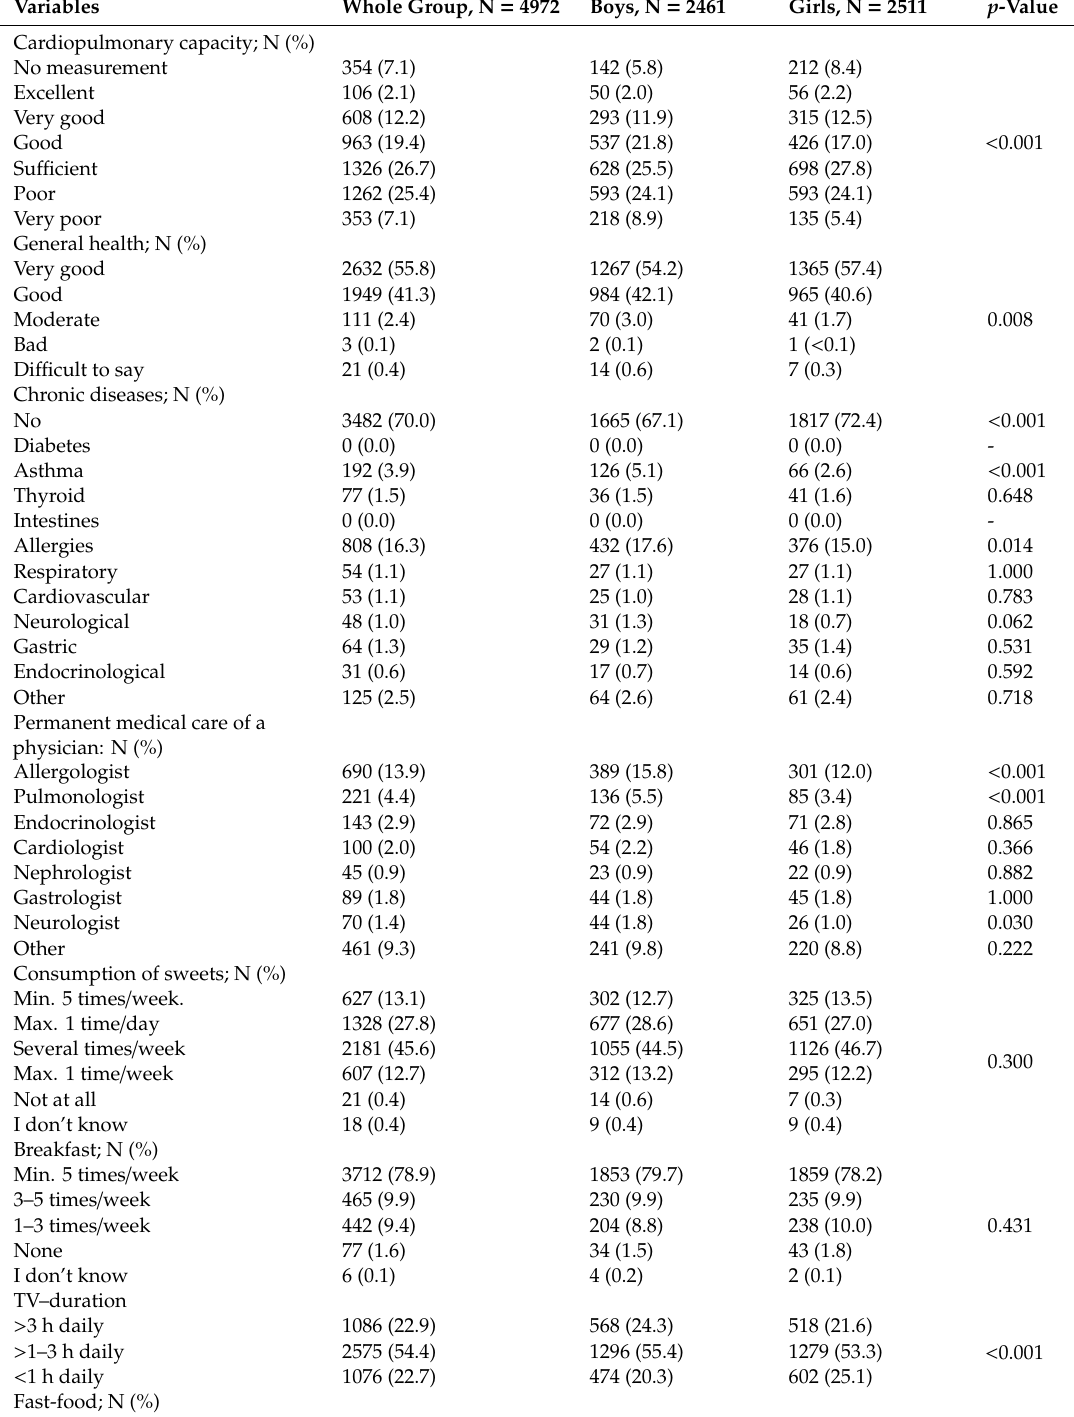
Table 2. Characteristics of health and nutrition of the examined boys and girls N (%) or M